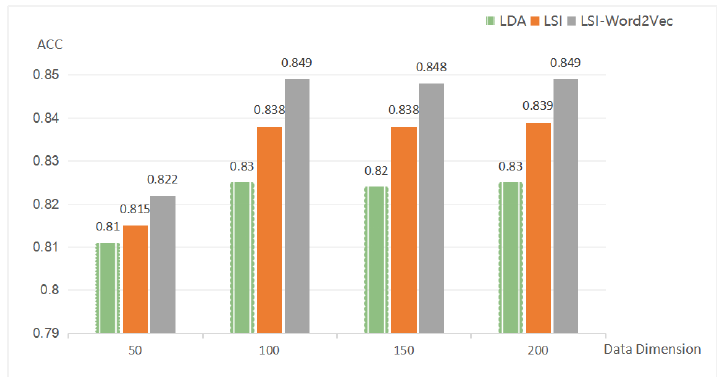
Figure 6. Comparison of the results from different dimensions.